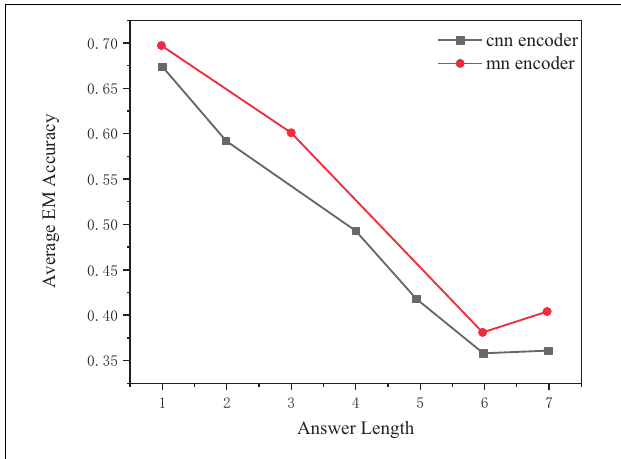
FIGURE 7 | Comparison of exact match (EM) scores of two models on different length answers.